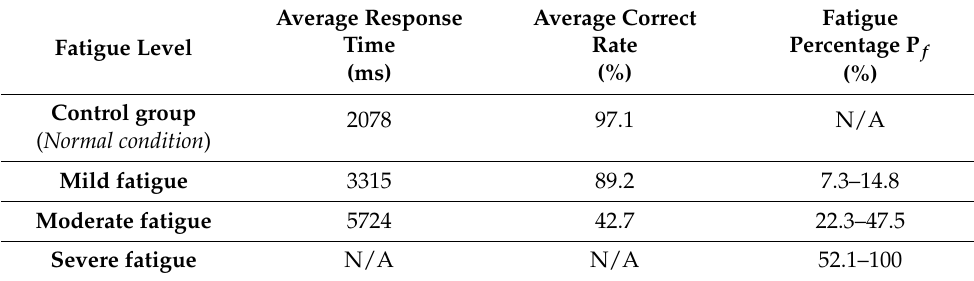
Table 3. Statistical results of fatigue class classification